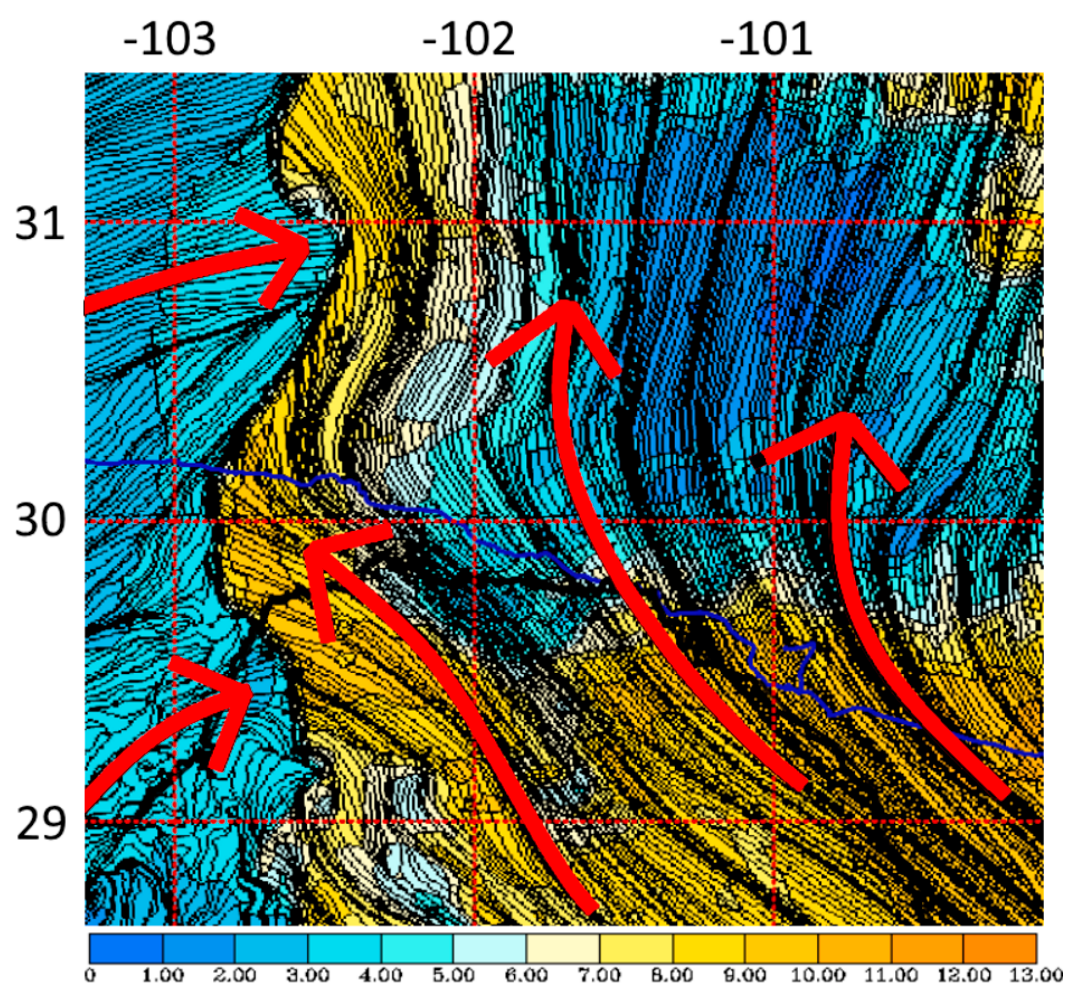
Figure 5. HRRR specific humidity (g/kg) and wind streamlines at 0.90 sigma level at 0000 UTC.